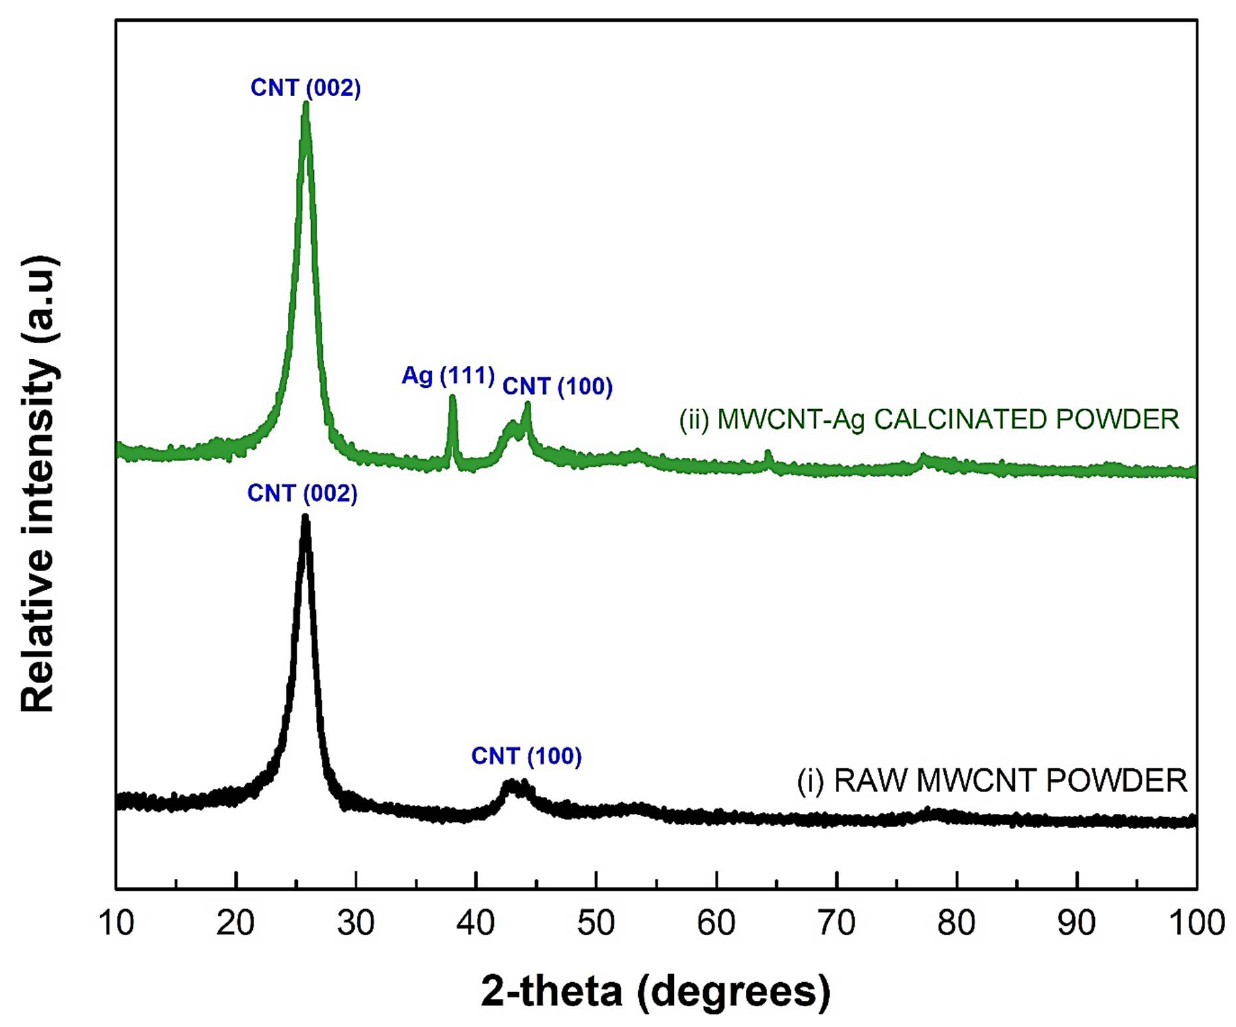
Figure 9. X-ray diffraction pattern for ( i ) raw MWCNT powder; ( ii ) MWCNT-Ag Figure 9. X-Ray diffraction pattern for ( i ) raw MWCNT powder; ( ii ) MWCNT-Ag powder.